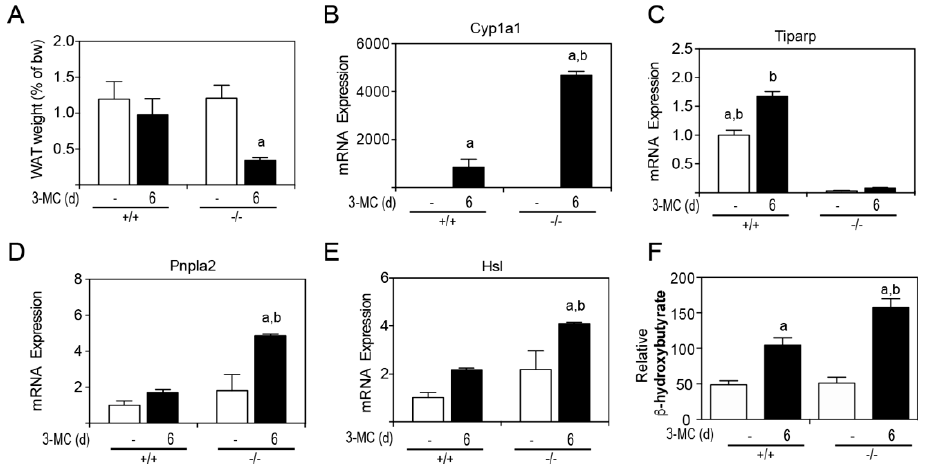
Figure 6. 3MC induces hepatosteatosis in WT but not in Tiparp -/- mice. ( A ) Gross liver images from corn oil- and 3MC-treated WT and Tiparp -/- mice at day 6. ( B ) Oil Red O staining was conducted to visualize neutral fats. Gene expression levels of Cd36, ( C ), Fasn ( D ), Srebp1 ( E ), and Cpt1a ( F ). Data represent the mean ± SEM of inflammatory genes; n = 3. a p < 0.05 two-way ANOVA comparison between genotype-matched corn oil- and 3MC-treated mice followed by a Tukey’s post hoc test for multiple comparisons.